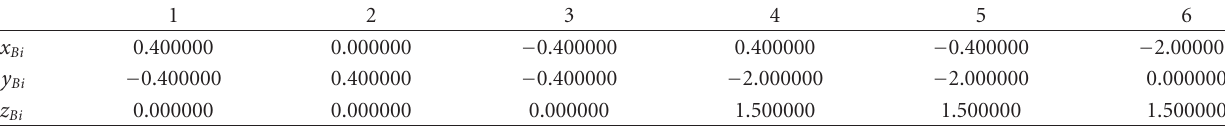
Table 1: The parameters of the base platform (m).